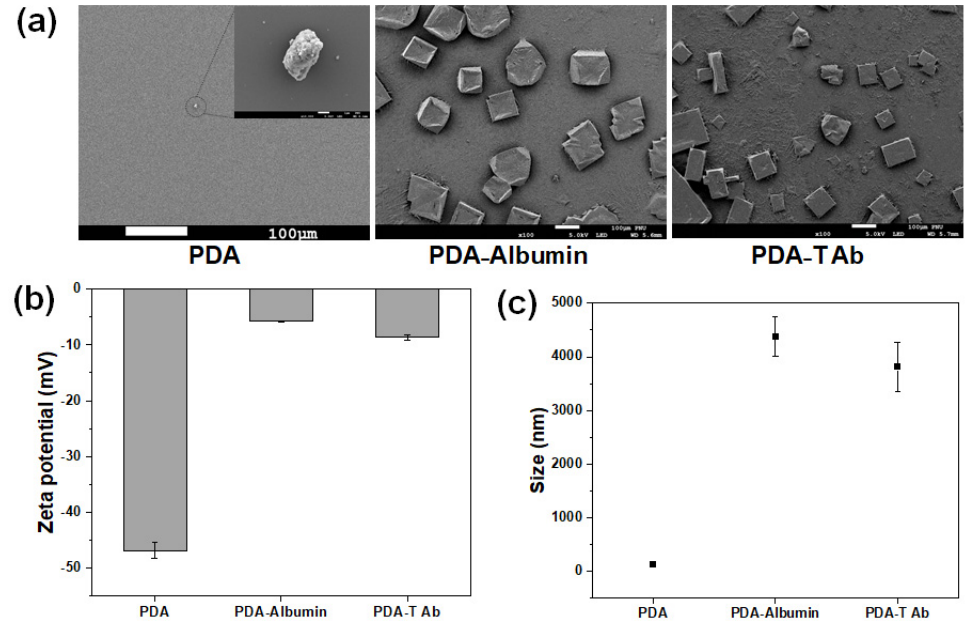
Figure 2. ( a ) SEM image of PDA, PDA-Albumin and PDA-T Ab. Scale bars represent 100 µm. The scale bar of the inset (magnified image) represents 1 µm. ( b ) Zeta potential values and ( c ) size of PDA, PDA-Albumin, and PDA-T Ab.